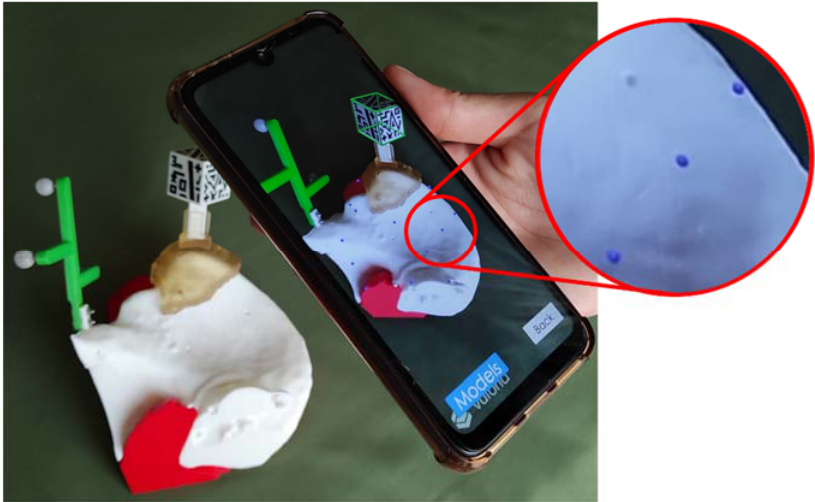
Figure 6. Phantom of patient AR3DP0002 (buttock tumor) and smartphone with the ARHealth validation app. The Augmented Reality Tracking Error validation spheres are augmented on the phantom surface in deep blue.